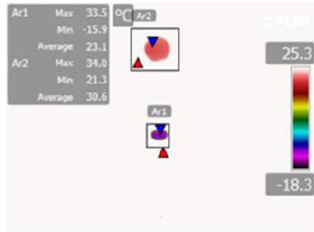
Figure 21. FLIR A325 thermal images of two levitated samples. The top sample is Styrofoam, the bottom one is a drop of dichloromethane approximately five seconds after introduction. The temperature of the Styrofoam is ambient ~21 ◦ C. The dichloromethane drop has cooled to ~ − 16 ◦ C, approximately 37 ◦ C below ambient temperature due to evaporative cooling. The blue and red triangles mark the low and high temperatures respectively measured in the selected area (Ar1 and 2) indicated by the boxes.